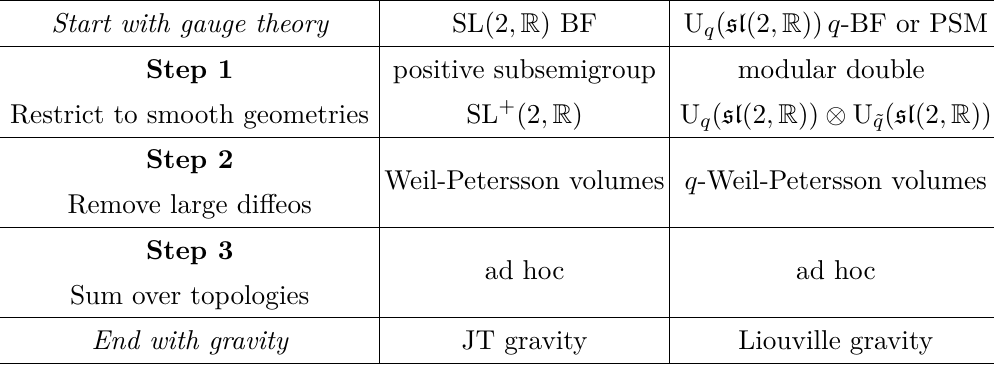
Table 1 . Passage from gauge theory to gravity as a multi-step